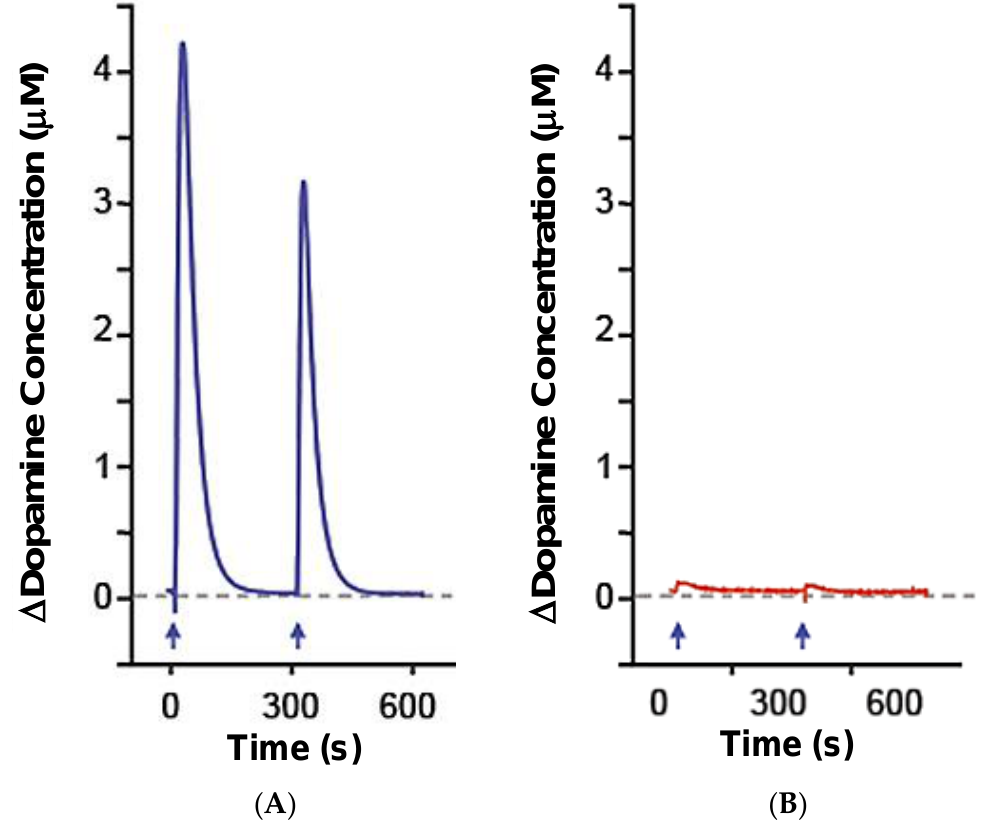
Figure 2. In vivo MEA-based measures of phasic DA neurotransmission. Representative traces of the DA signal measured on DA (solid line) and sentinel (dashed line) recording sites following the local application of KCl (100 nL; 120 mM, pH 7.4) in the dorsal striatum (dSTR) of anesthetized non-lesioned (( A )–Blue) or 6-hydroxydopamine (6-OHDA) lesioned (( B )—Red) rats.